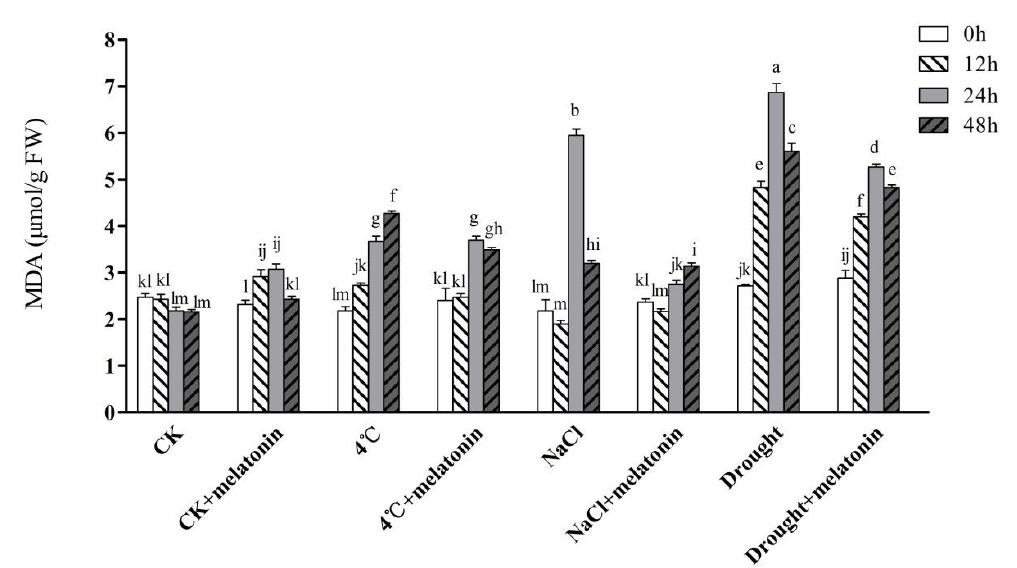
Figure 2. Effect of exogenous melatonin on malondialdehyde (MDA) contents in tea leaves on the designated times. The tea plants were subjected to control (CK), cold stress (4 °C), high salt (300 mM NaCl) and drought stress (200 g·L −1 PEG) with different treatments (CK and 100 μM melatonin). Data represent means ± SD of three replicate samples. Different letters indicate significant differences according to Duncan’s multiple range test ( P < 0.05).